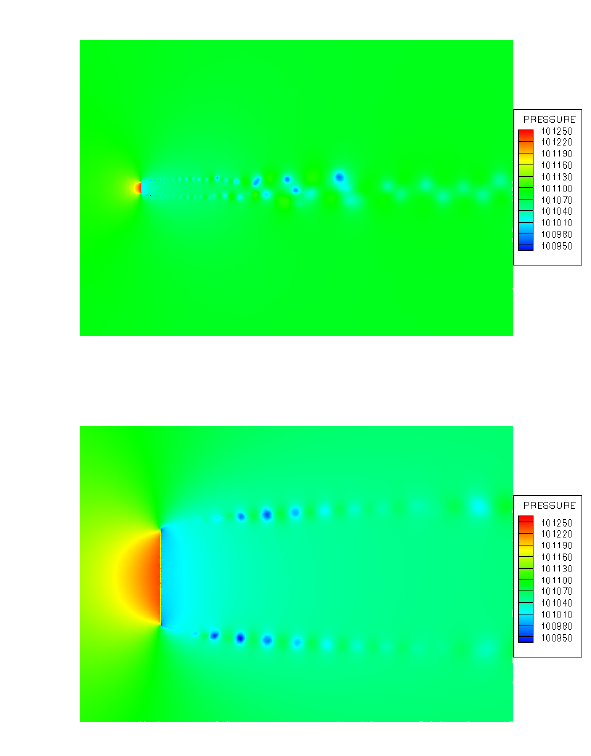
Fig. 7. The distribution of the velocity for the porous media for 30 ms − 1